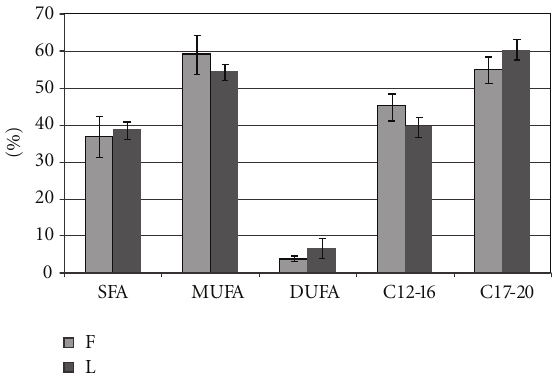
Figure 4: Comparison of the carbohydrate chain length and degree of saturation of fatty acids, the components of deep- frozen (F) and lyophilized (L) compact part of the human bone (SFA: saturated fatty acids; MUSFA: monounsaturated fatty acids; DUSFA: diunsaturated fatty acids; C12–16: fatty acids with chain length of 12 to 16 carbons; C17–20: fatty acids with chain length of 17 to 20 carbons).